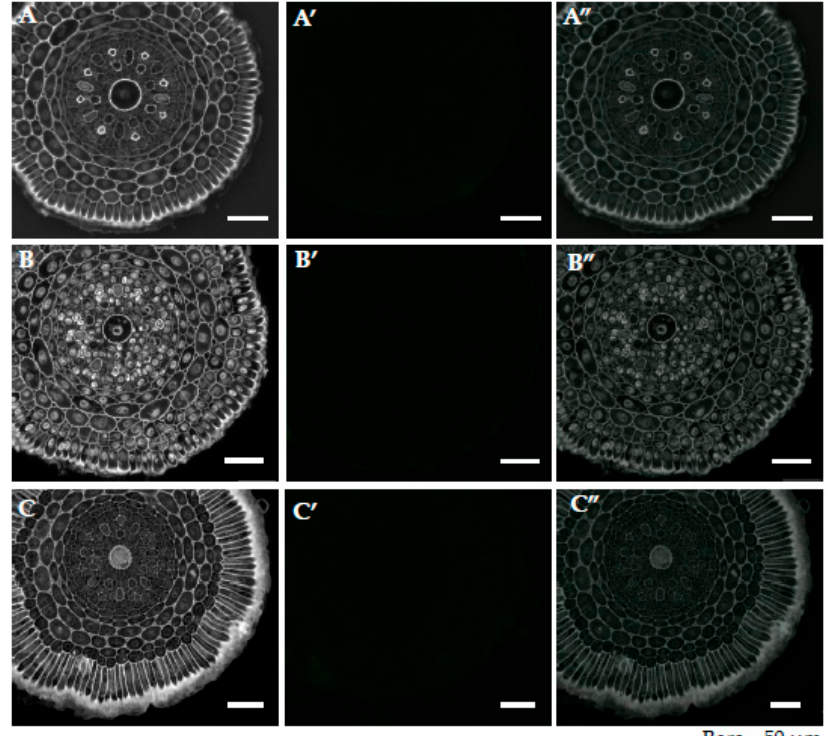
Figure A1. The example of the negative control for the immunolocalization of pectin epitopes in cross sections in differentiated zone of root tissues of barley cv. Sebastian. ( A )—control pH 6;